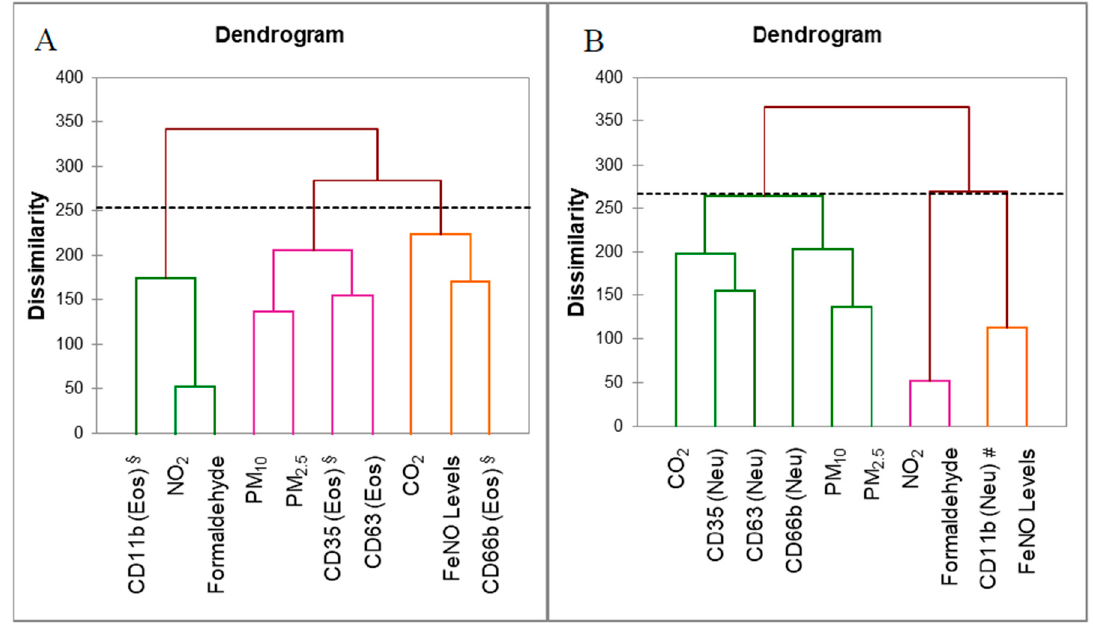
Figure 3. Agglomerative hierarchical clustering (AHC) analysis using the Ward linkage method and using Euclidean distances to generate the clustering of degranulation and the activation of markers and environmental pollutants measured inside classrooms for ( A ) eosinophils and ( B ) neutrophils. The dotted line represents the pruning level to generate distinct clusters. § Activation marker for eosinophils; # Activation marker for neutrophils. Table 4. Summary of the binary logistic regression models based on the clusters generated in the AHC